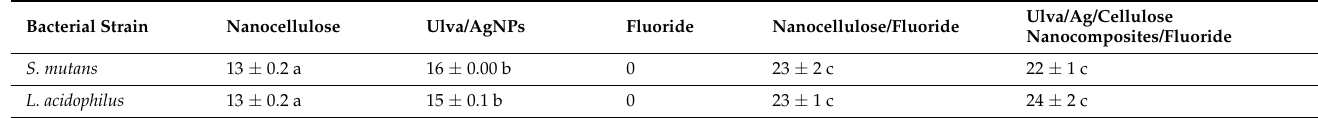
Table 4. Inhibition zone diameter (mm) of S. mutans ATCC 25175 and L. acidophilus CH-2 of Ulva/cellulose and Ulva/Ag/cellulose nanocomposites that were blended with fluoride. (Different letters denote significance value p < 0.05).